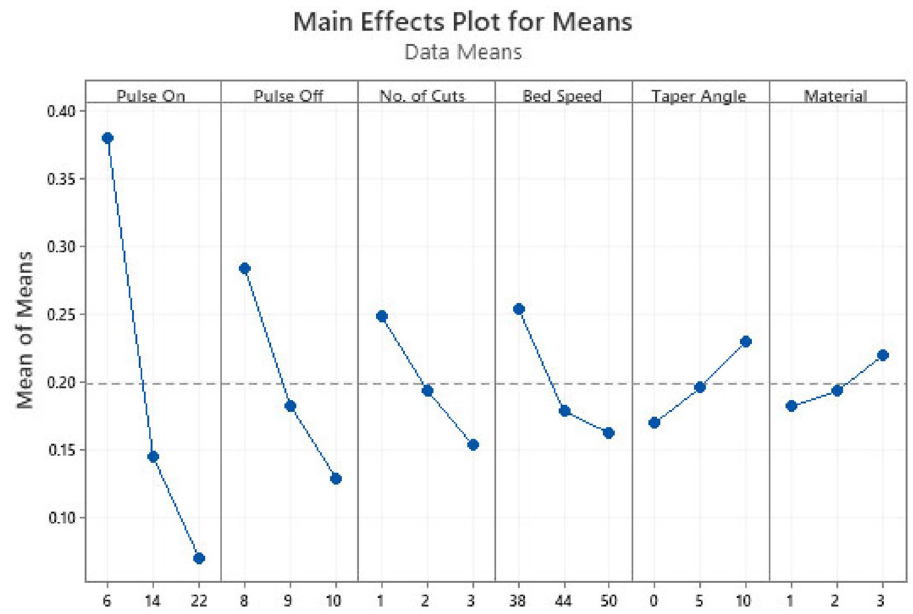
Fig. 11 Main effects plot for means ( ERR